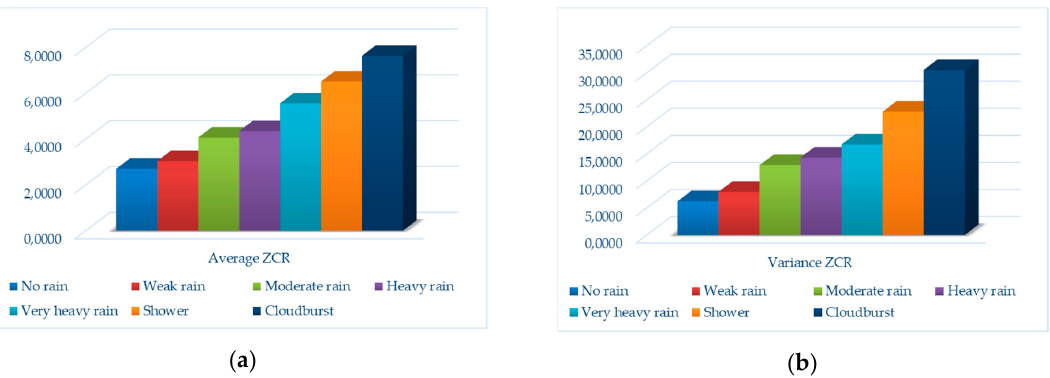
Figure 9. ZCR values for di ff erent rainfall classification levels: ( a ) average of ZCR values; ( b ) variance of ZCR values.